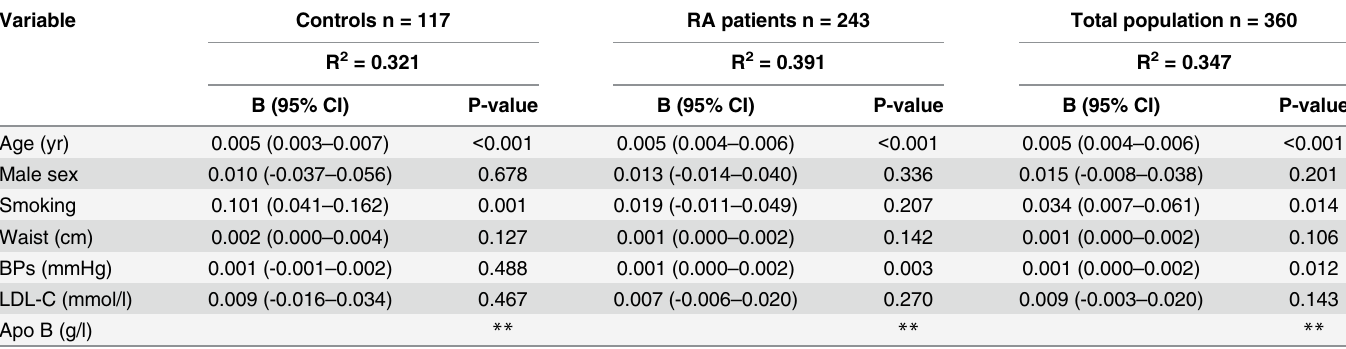
Table 3. Multivariable regression analysis with identified covariables associated with cIMT.